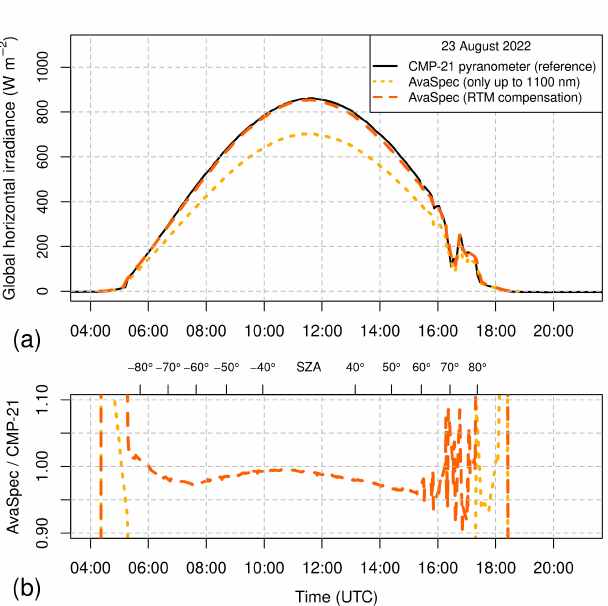
Figure 11. ( a ) Evolution of the global horizontal irradiance on 23 August 2022 (P1). The lines correspond to measurements from the CMP-21 pyranometer (black) as well as spectra from the AvaSpec integrated only up to 1100 nm (yellow, dotted line) and from the AvaSpec after RTM compensation for the unmeasured part of the spectrum (orange, dashed line). ( b ) Ratio between the GHI from the AvaSpec and from the CMP-21 pyranometer, as a function of time of the day and solar zenith angle (SZA, upper axis; negative values referring to morning, positive to afternoon). Cirrus clouds perturb the measurements in the late afternoon.